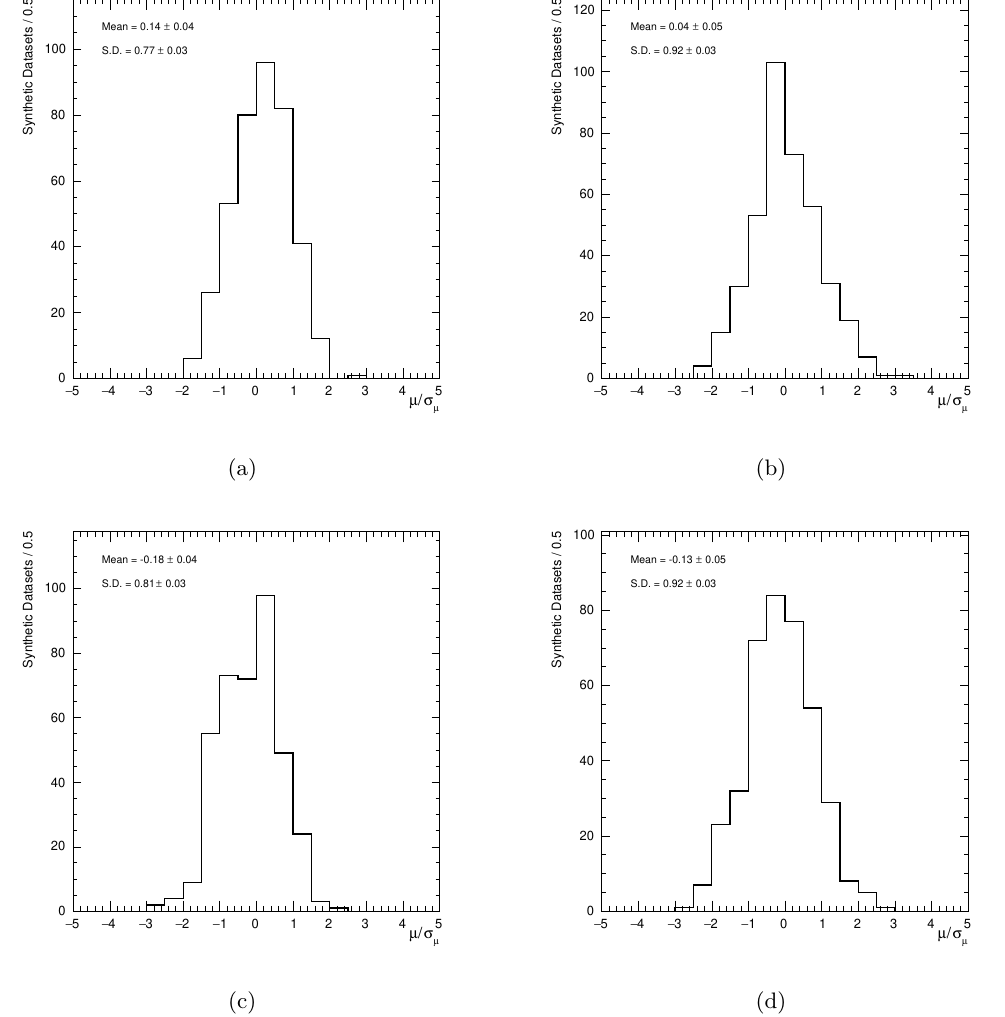
Figure 8 . Ensemble test distributions of fitted signal strength, normalised to uncertainty, for each of the two mass hypotheses considered: (a) and (b) signal located on kinematic peak of m ( φ, γ ) distribution, (c) and (d) signal located on smoothly falling region of m ( φ, γ ) distribution. In (a) and (c) the background model is obtained by using once each of the n events in the GR, while in (b) and (d) the GR is sampled n